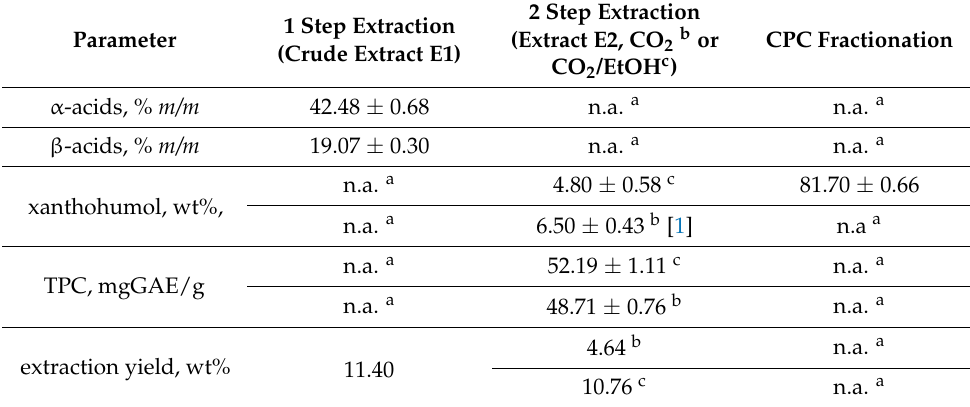
Table 2. The chemical composition of obtained extract (E1 and E2) and CPC